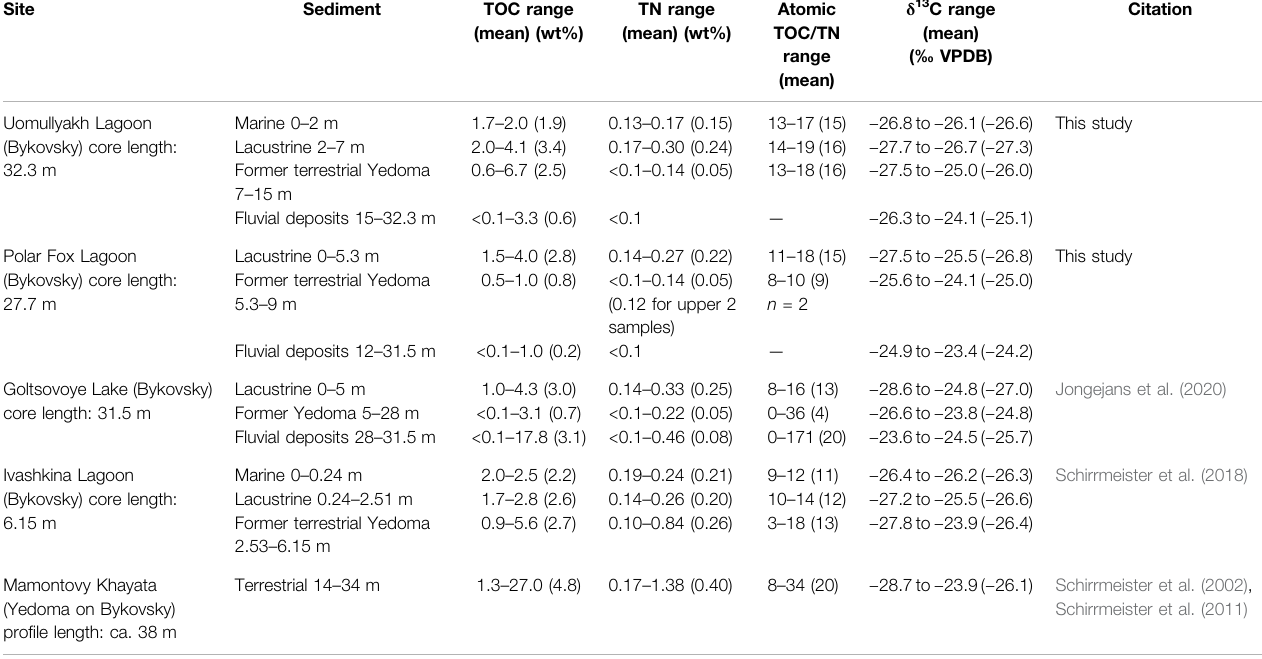
TABLE 4 | Comparison of biogeochemistry characteristics with different lagoons, Yedoma sites and a thermokarst lake: total organic carbon content (TOC), total nitrogen (TN), atomic carbon nitrogen ratio, stable carbon isotope composition ( δ 13 C). Note that given depth are measured from the sediment surface for better comparability of the